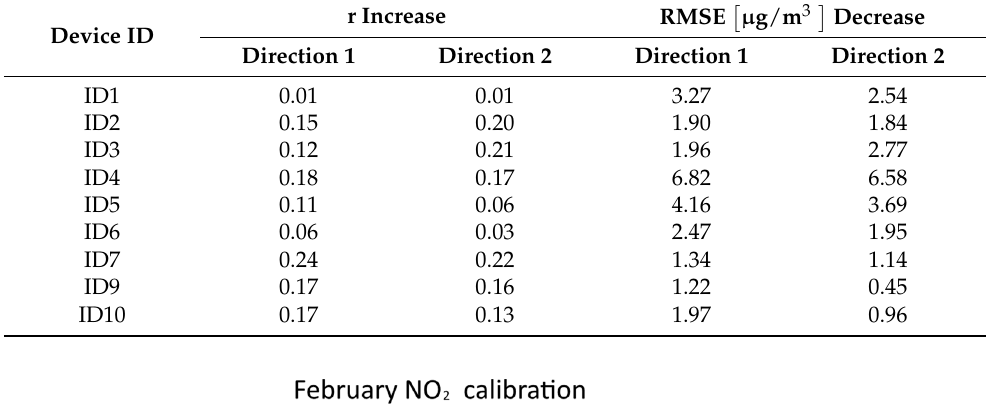
Table 2. Results of the NO 2 calibration propagation in February, improvements in comparison to the parameters before calibration.